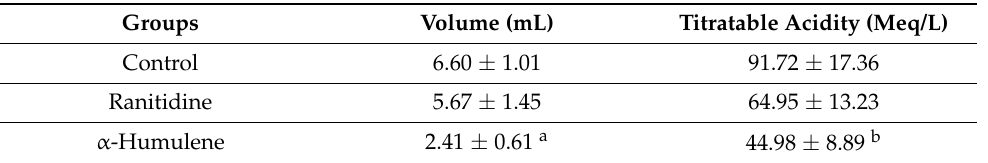
Values are mean ± standard deviation ( n = 5). a,b Means with the different letters in the column are significantly different ( p < 0.05) by Duncan’s multiple range